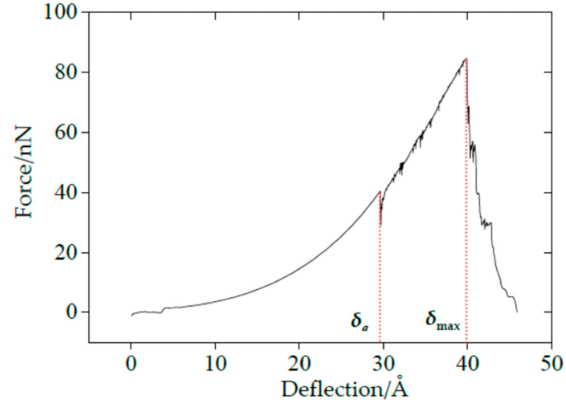
Figure 1. The force–deflection curve of SLMoS2